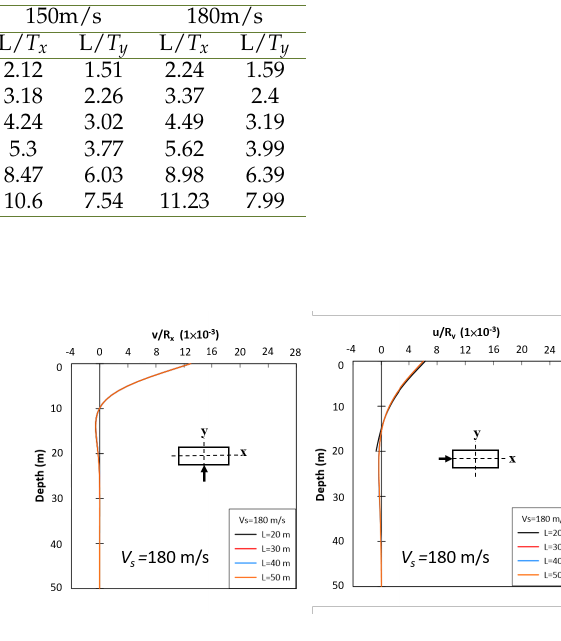
Fig. 15. Normalized deflections of the barrette in clays ( v s =180m/s)